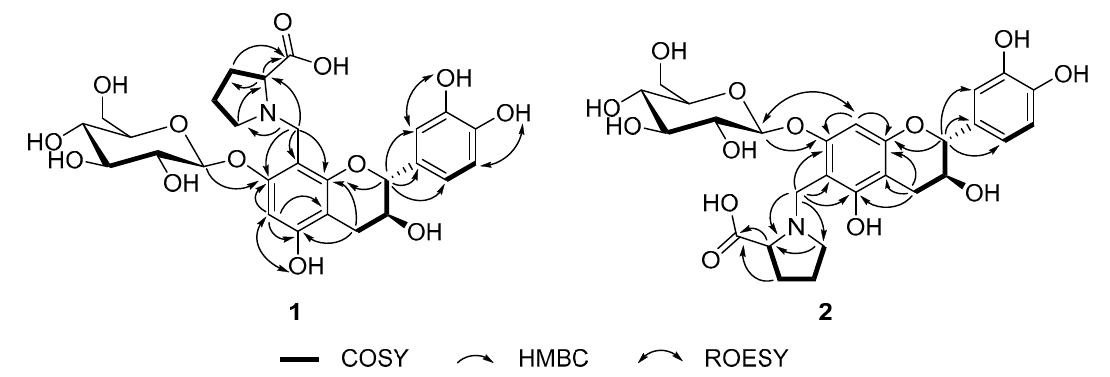
Figure 2. Key COSY, HMBC and ROESY correlations for 1 and 2 .